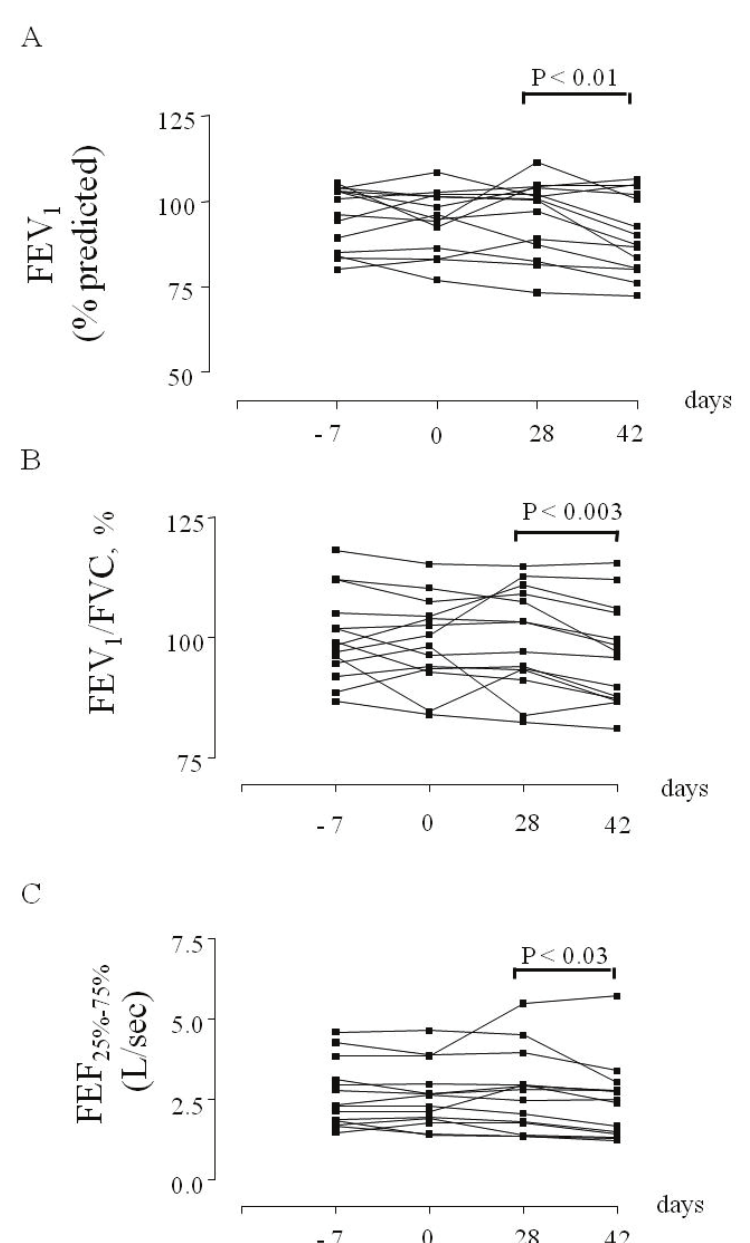
Figure 2. FEV percentage of predicted values (A), FEV 1 FEF values (C) in children with asthma (n = 14) at baseline (day -7), before 25%–75% treatment with montelukast (day 0), after treatment with oral montelukast (5 mg qd for four weeks) (day 28), and two weeks after montelukast withdrawal (day